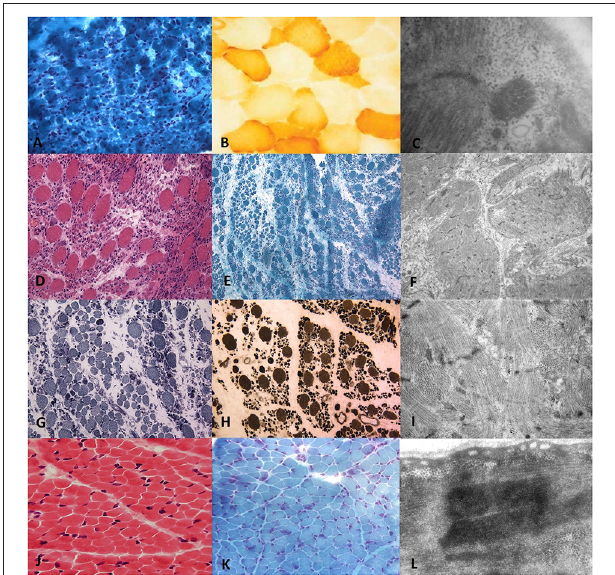
FIGURE 1 | Histopathological and ultrastructural features on transverse sections of muscle biopsy of RYR1 -RCM. Muscle biopsy from Patient I performed at 5 days of life in the first line. (A) Gomori Trichromic staining showed fiber size variability; (B) Tiny cytochrome-C oxidase deficiency at COX staining; (C) Central core and rod-core elements at electron microscopy. Muscle biopsy from Patient II was performed at 37 days of life in the second and third lines. (D) Severe type I fibers hypotrophy at Hematoxylin-Eosin, (E) Gomori trichromic, (G) NADH-TR, and (H) ATPase after acid preincubation showing predominance of darker staining hypotrophic type 1 fibers. (F,I) Electron microscopy showing focal areas of sarcomeric abnormalities with Z-line streaming and, in rare fibers, subsarcolemmal and intermyofibrillar deposits of free glycogen. Muscle biopsy from Patient III.1 was performed at 2 years of age in the fourth line. Fiber size variability with fiber I hypotrophy, fiber splittings, and moderate connective tissue increase (J) Hematoxylin-Eosin and (K) Gomori Trichromic; (L) Z-line streaming at electron microscopy.